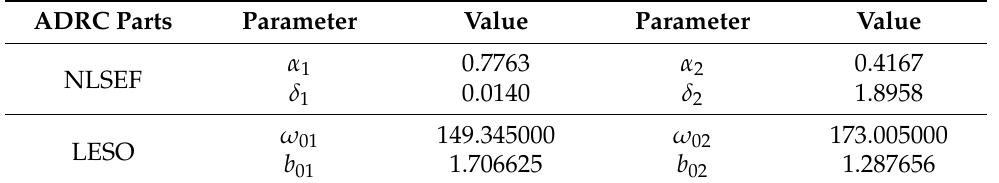
Table 7. ADRC parameters.